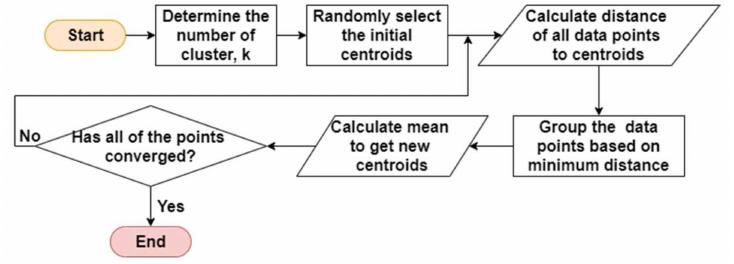
Figure 2. Basic steps of k-means